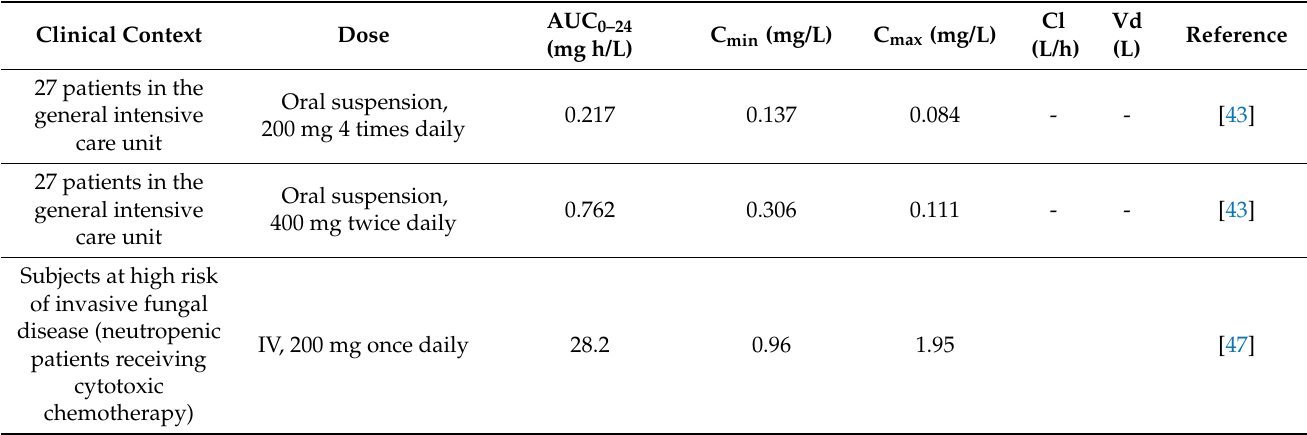
Table 2. Summary of Clinical Studies Assessing PK Parameters of